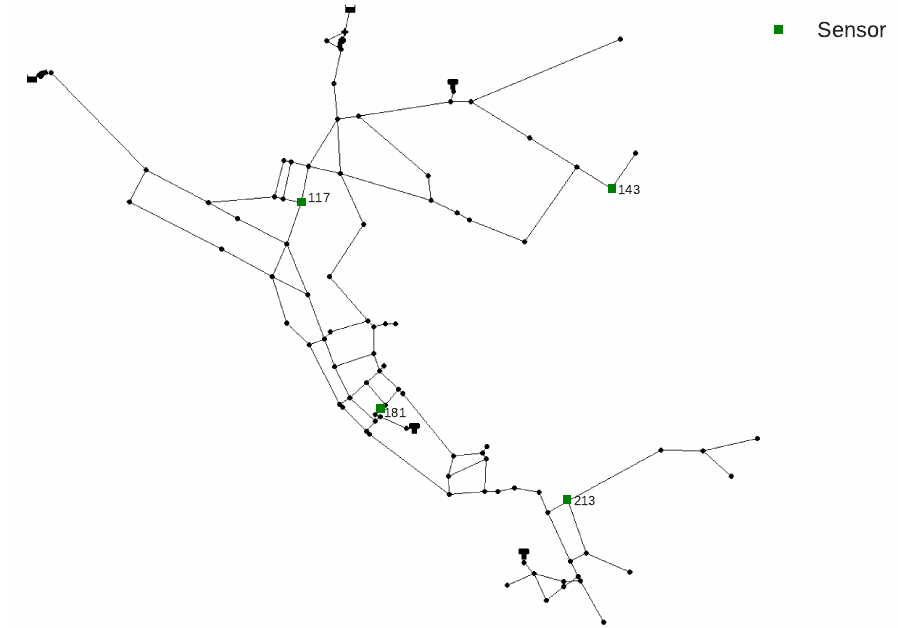
Figure 1. Net3 water supply network layout with sensor positioning by Preis and Ostfeld [7].